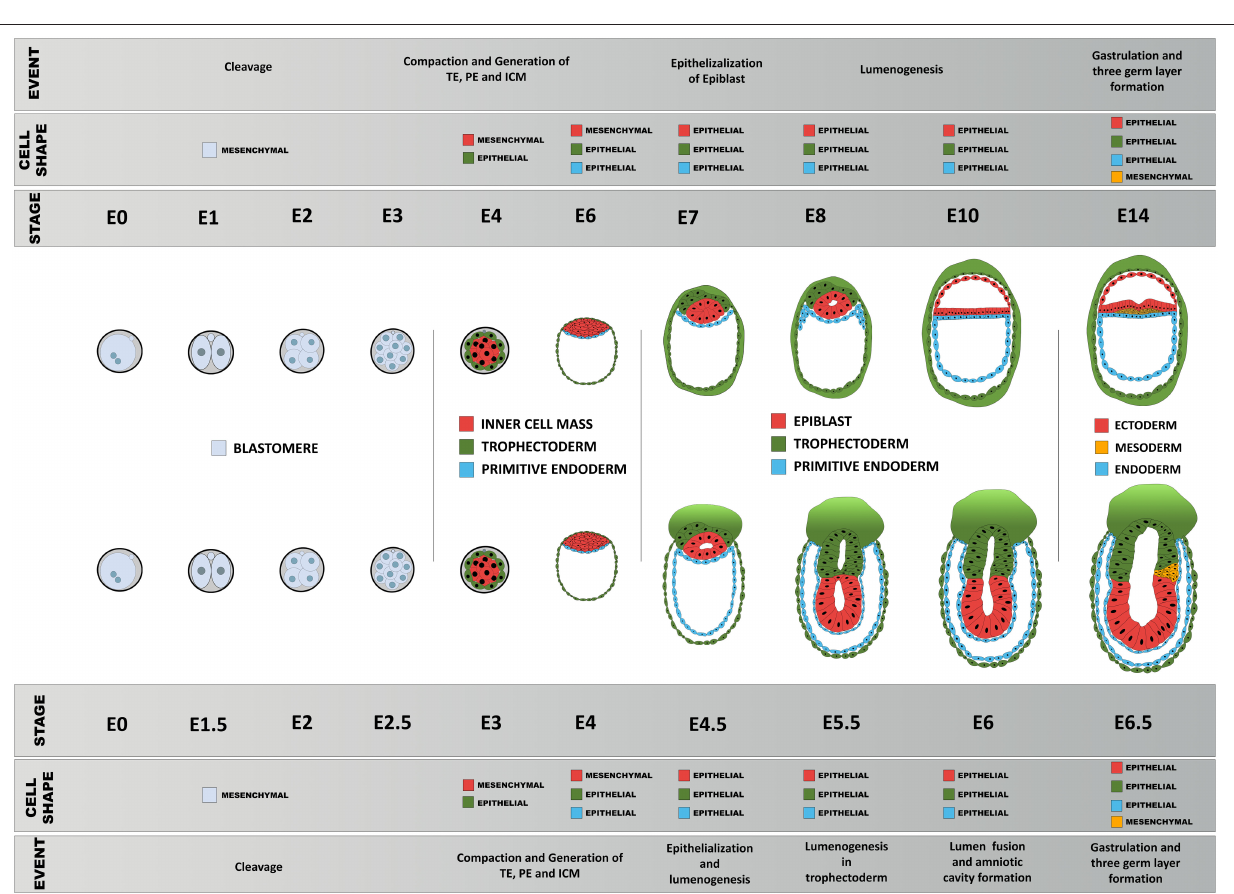
FIGURE 5 | Schematic diagram of comparison of early morphogenesis in the human and mouse. Upon fertilization, mouse and human embryos undergo a series of morphological changes, primarily as a consequence of the interplay between their epithelial and mesenchymal status, pluripotency, biomechanical forces, and morphogen signaling. Blastomeres show little apicobasal polarization before compaction between 8 → 16 cell stage that results in the first lineage specification: epithelialized trophoblast and non-polar inner cell mass. The primitive endoderm precursors then undergo epithelialization followed by a gradual polarization process of the epiblast precursors, resulting in formation of the proamniotic cavity and an epithelial epiblast that will be maintained until the next major transformation event during